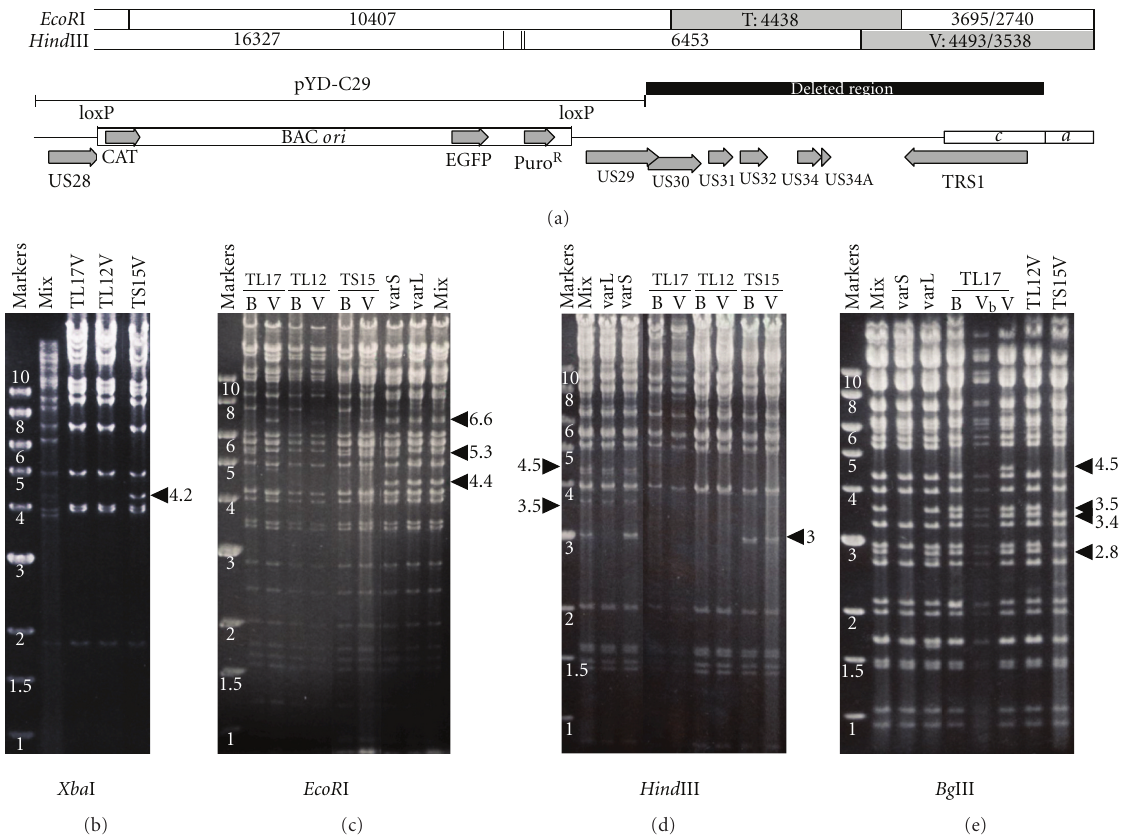
Figure 2: Restriction analysis of BACs and BAC-derived viral genomes. (a) Eco RI and Hin dIII restriction maps illustrate restriction fragments near the right end of BAC-cloned genomes that retain BAC ori . Eco RI T and Hin dIII V fragments (grey) are designated [17]. Genetic features of this region are illustrated, including the US28 , BAC ori cassette, and US29 sequences in pYD-C29, CMV genes US29 to TRS1 , and c repeat with single terminal a sequence. (b–e) Restriction digests of virion DNAs made from the vaccine virus mixture (mix) or varS and varL viruses isolated from the vaccine, virions from BAC-derived viruses (V), or circular BAC DNAs (B). V b indicates TL17 virion DNA that retains the BAC ori ; in all other BAC-derived viruses the BAC ori was excised. 4.2kb Xba I, 5.3 kb Eco RI, and 3.0kb Hind III fragments are unique to varS genomes, while 2.8 and 3.5 kb Bgl II fragments are unique to varL genomes. BACs lack 4.5 and 3.5kb Hin dIII and 4.4 kb Eco RI fragments due to deletions and a 6.6kb Eco RI terminal fragment because they are circular. All BACs contain an unexpected 3.4kb Bgl II fragment due to a point mutation in the recombination vector. A 4.5 kbBg l II fragment that may arise from a single copy of the a sequence is unique to TL17 virus with excised BAC ori